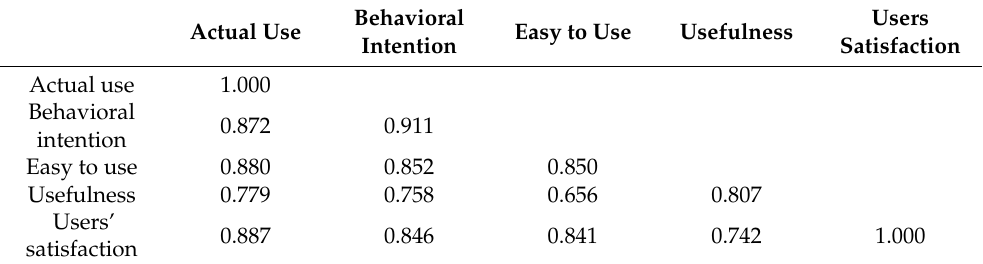
Table 4. Discriminant validity.